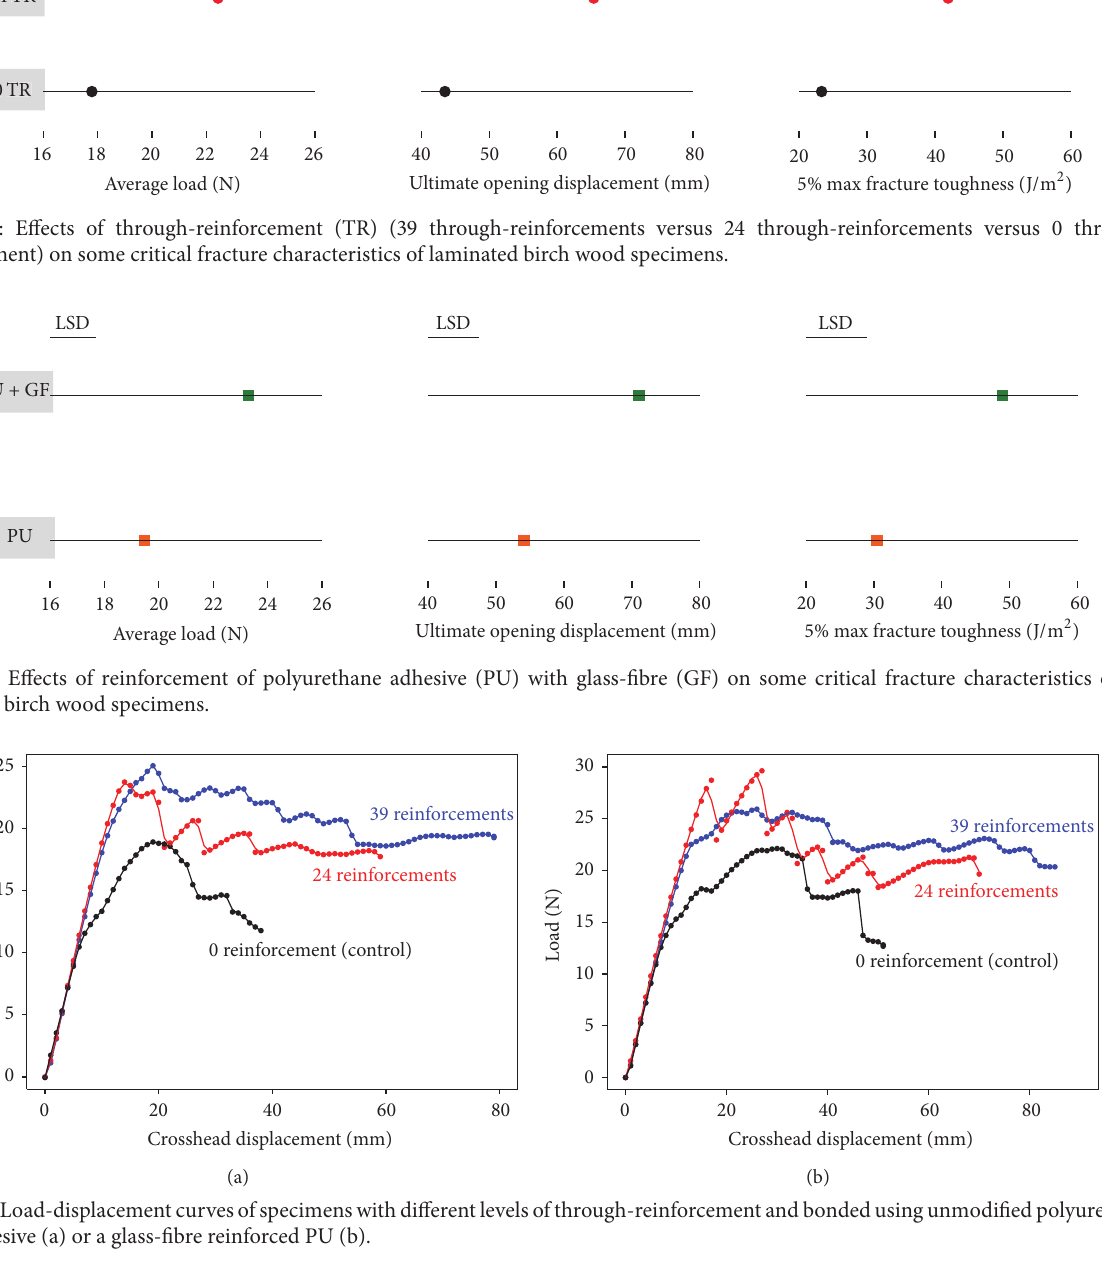
through-reinforcement, and also adhesive bond-line rein- forcement on the fracture toughness of the birch wood